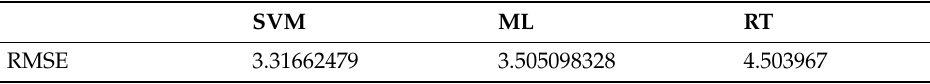
Table 4. RMSE for the classification of 7 class (LULC).